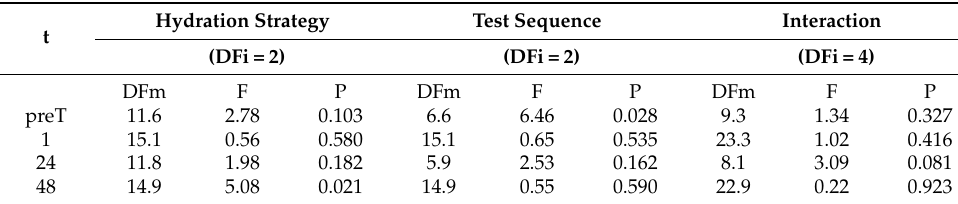
Table 15. Results of analysis of variance for interleukin 1 β measured before the test (preT) and 1, 24, and 48 h after the exercise test: significance of (P) and F-statistic along with the number of degrees of freedom (DFi—in the numerator; DFm—in the denominator) for the fixed effects (hydration strategy, test sequence, and their interaction).